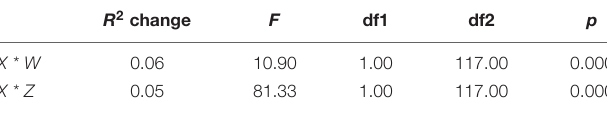
TABLE 12 | R 2 increase due to interaction: WtWE (work-related